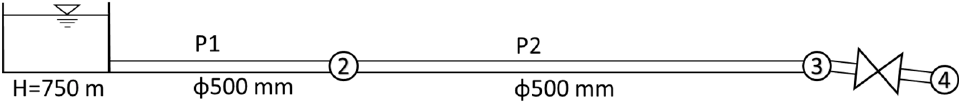
Figure 1. The layout of the first case study describes a simple pipeline system with a junction and a valve downstream.